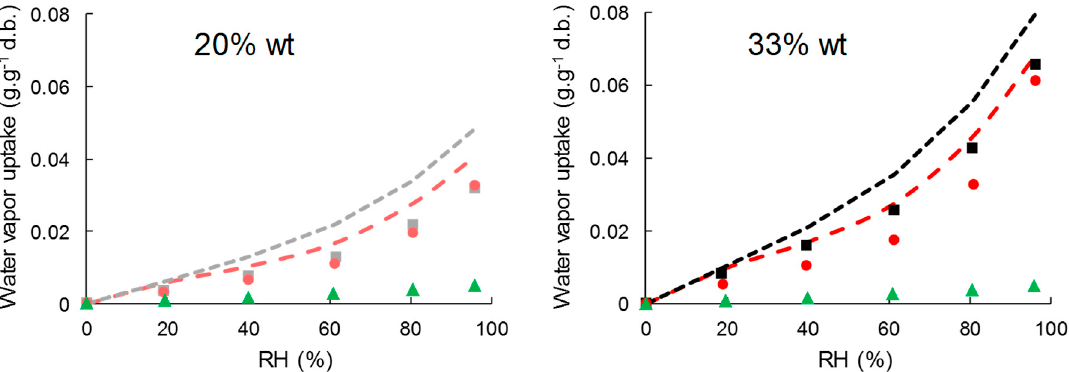
Figure 5. Simulated sorption isotherms from Equation (9) for PHBV-based composites: PHBV ( ▲ ), PHBV-20VC ( - - ), PHBV-20GC ( - - ), PHBV-33VC ( - - ), PHBV-33GC ( - - ).